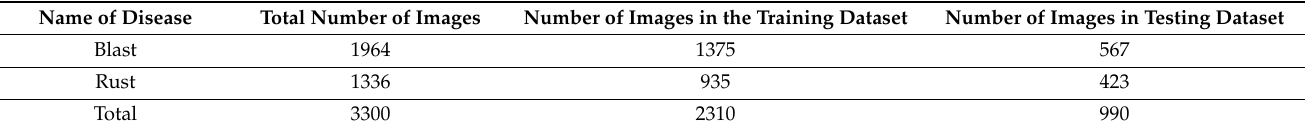
Table 2. Number of images in training and testing datasets of blast and rust.